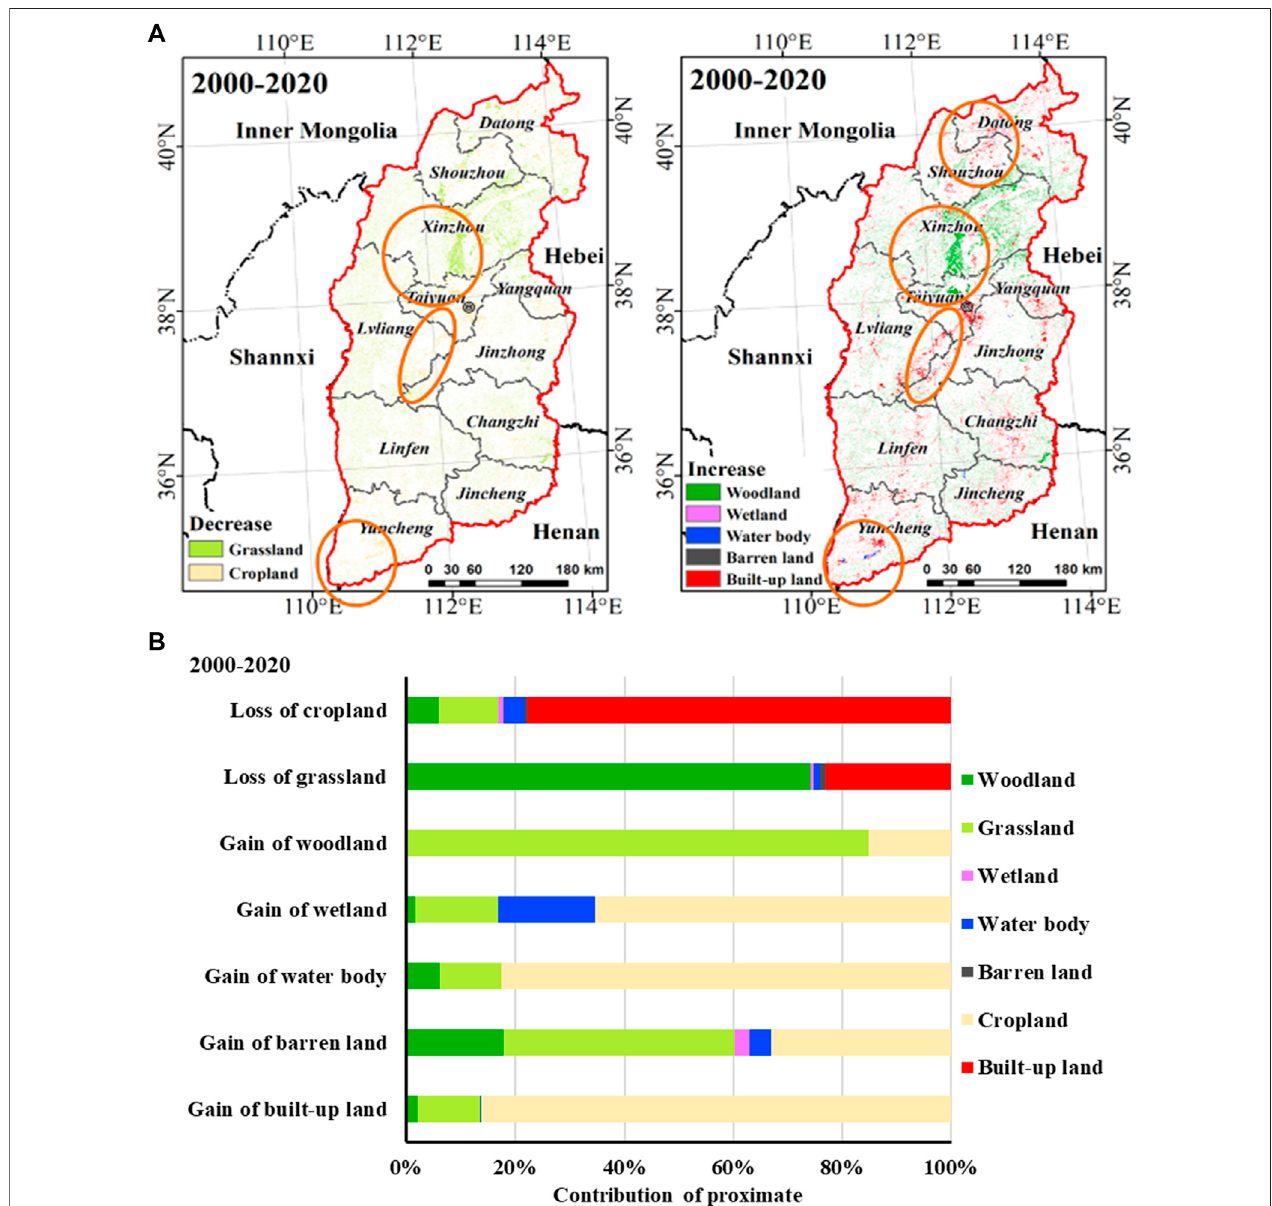
FIGURE 3 | The spatial location (A) and contribution of proximate driver (B) of decreasing and increasing land cover type.